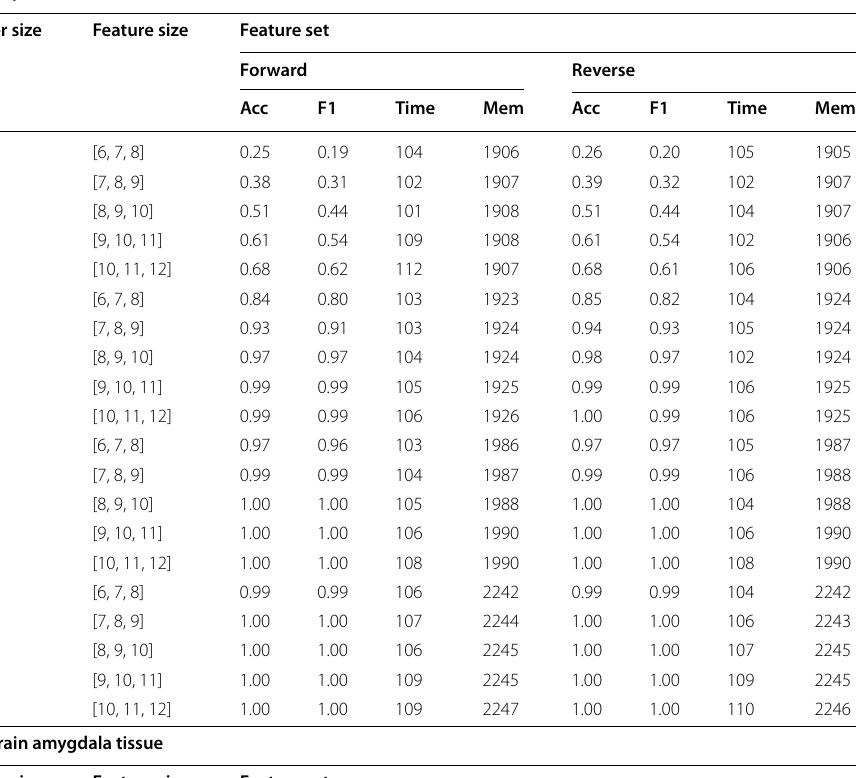
Table 2 Effect of varying k-mer and feature sizes on the Adipose subcutaneous tissue representing the Test-1 dataset and the Brain amygdala tissue representing the Test-2 dataset (a) Adipose subcutaneous tissue k‑mer